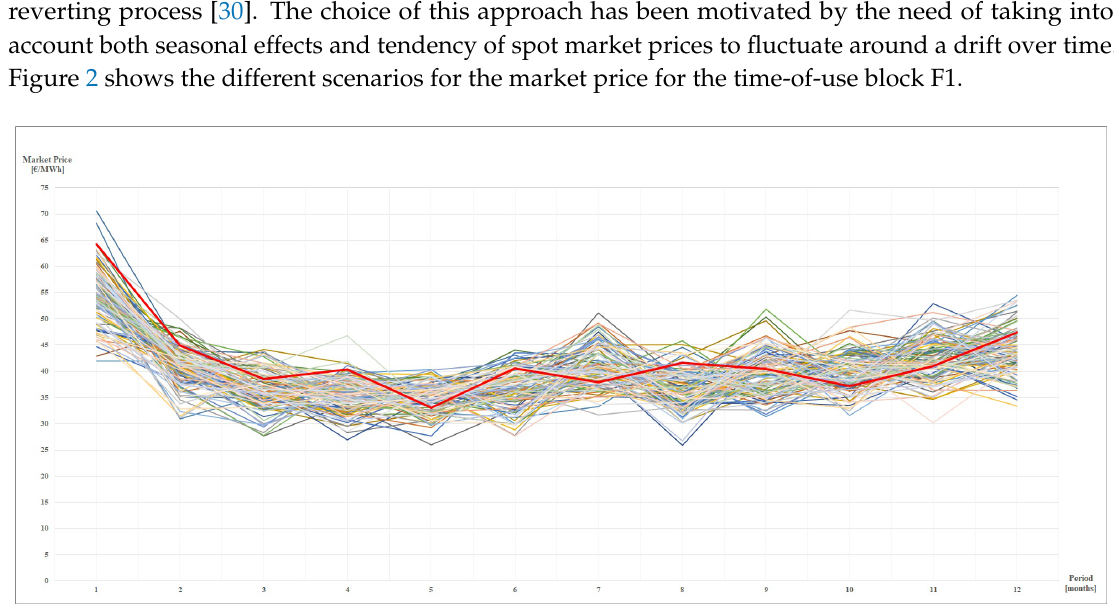
Figure 2. Scenarios for the market electricity